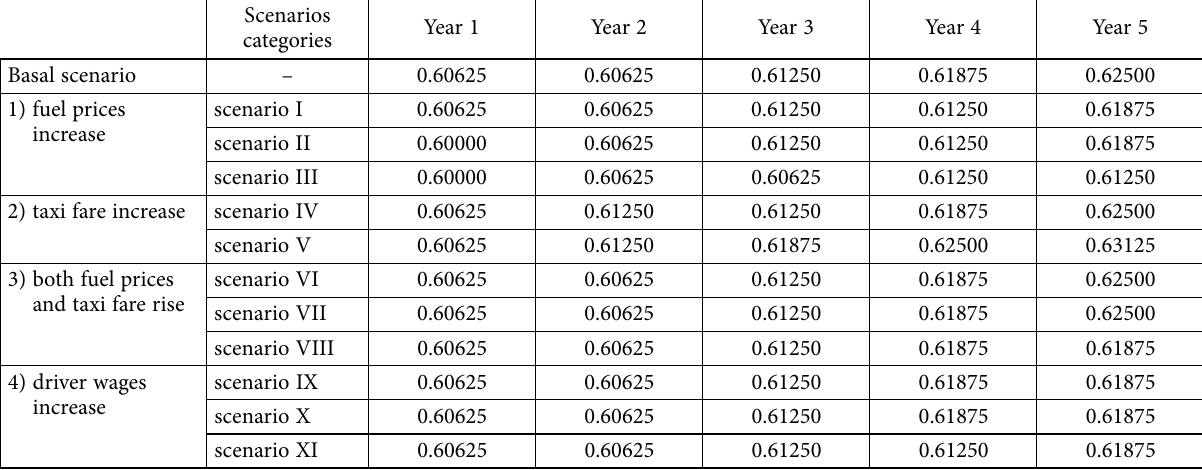
Table A3. The statistics of level of service for taxi operation